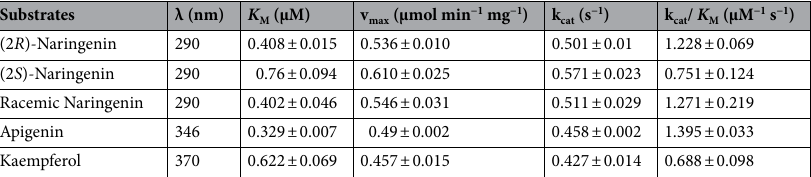
Table 4. Kinetic parameters of purified recombinant membrane bound Dv CH3H. λ indicates the wavelength used for quantification of the reaction product.